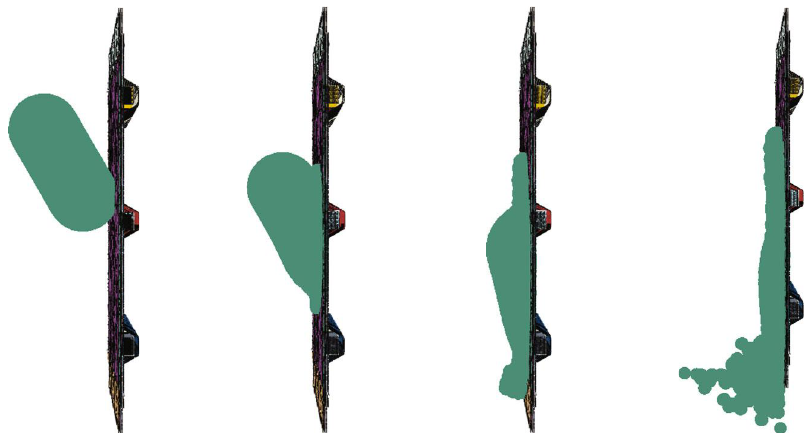
Figure 18: Morphology of the bird body at di ff erent moments of 30 °